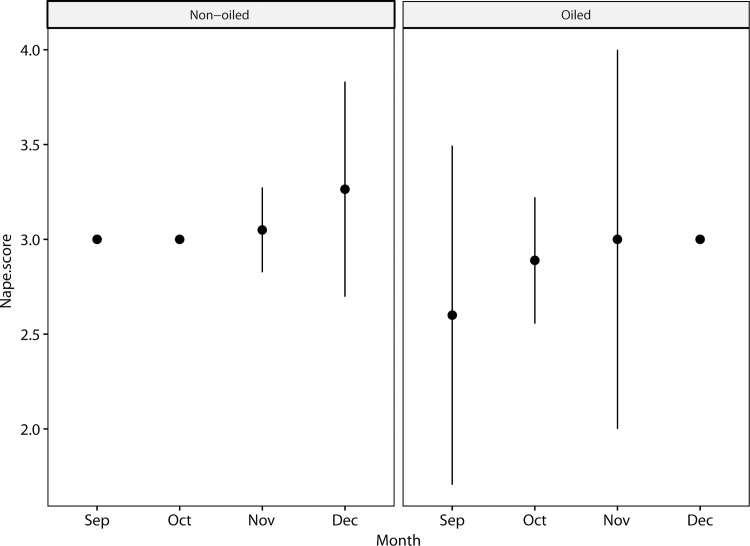
Hindneck scores compared for non-oiled and oiled pelicans, showing monthly mean and standard deviation.The oiled group includes pelicans released with band-only and GPS-PTT tags (N = 21). The non-oiled group includes only unmarked pelicans (N = 135) and does not include pelicans bearing GPS-PTT tags. Data are from September 15-December 15, 2015. Differences in neck molt between groups were not significant according to loglinear analysis (see text).